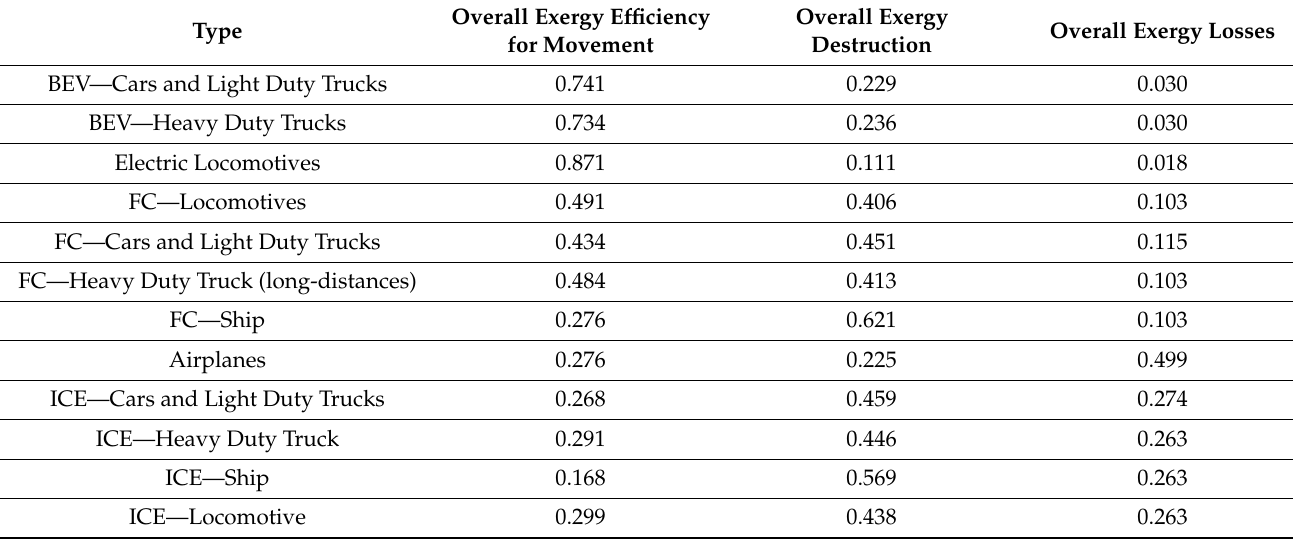
Table A6. Available conversion units for covering transport demand of the scenario Energy Efficiency [47].